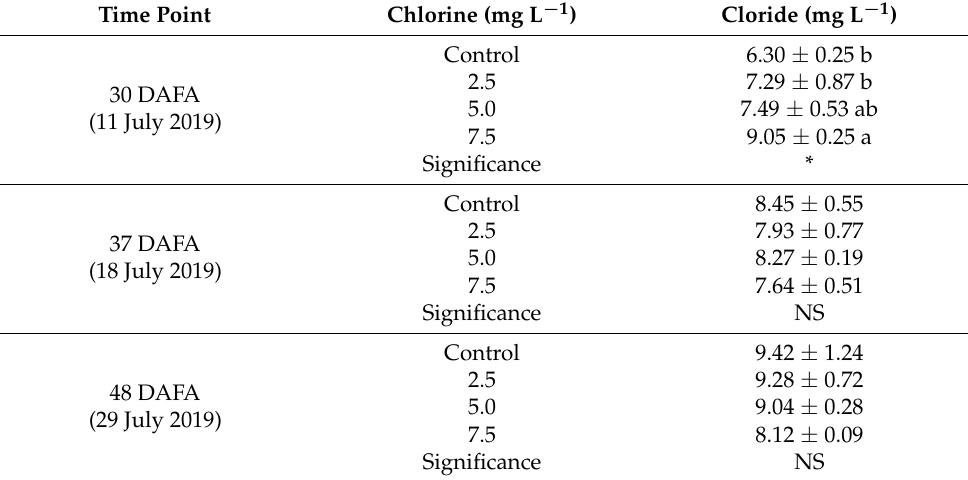
Table 1. Chloride concentration in the drainage solution samples collected at 30, 37, and 48 DAFA of sodium hypochlorite in a soilless cultivation of tomato. Sodium hypochlorite was applied at concentrations of 2.5, 5.0, and 7.5 mg L − 1 of chlorine, while in the control treatment no sodium hypochlorite was